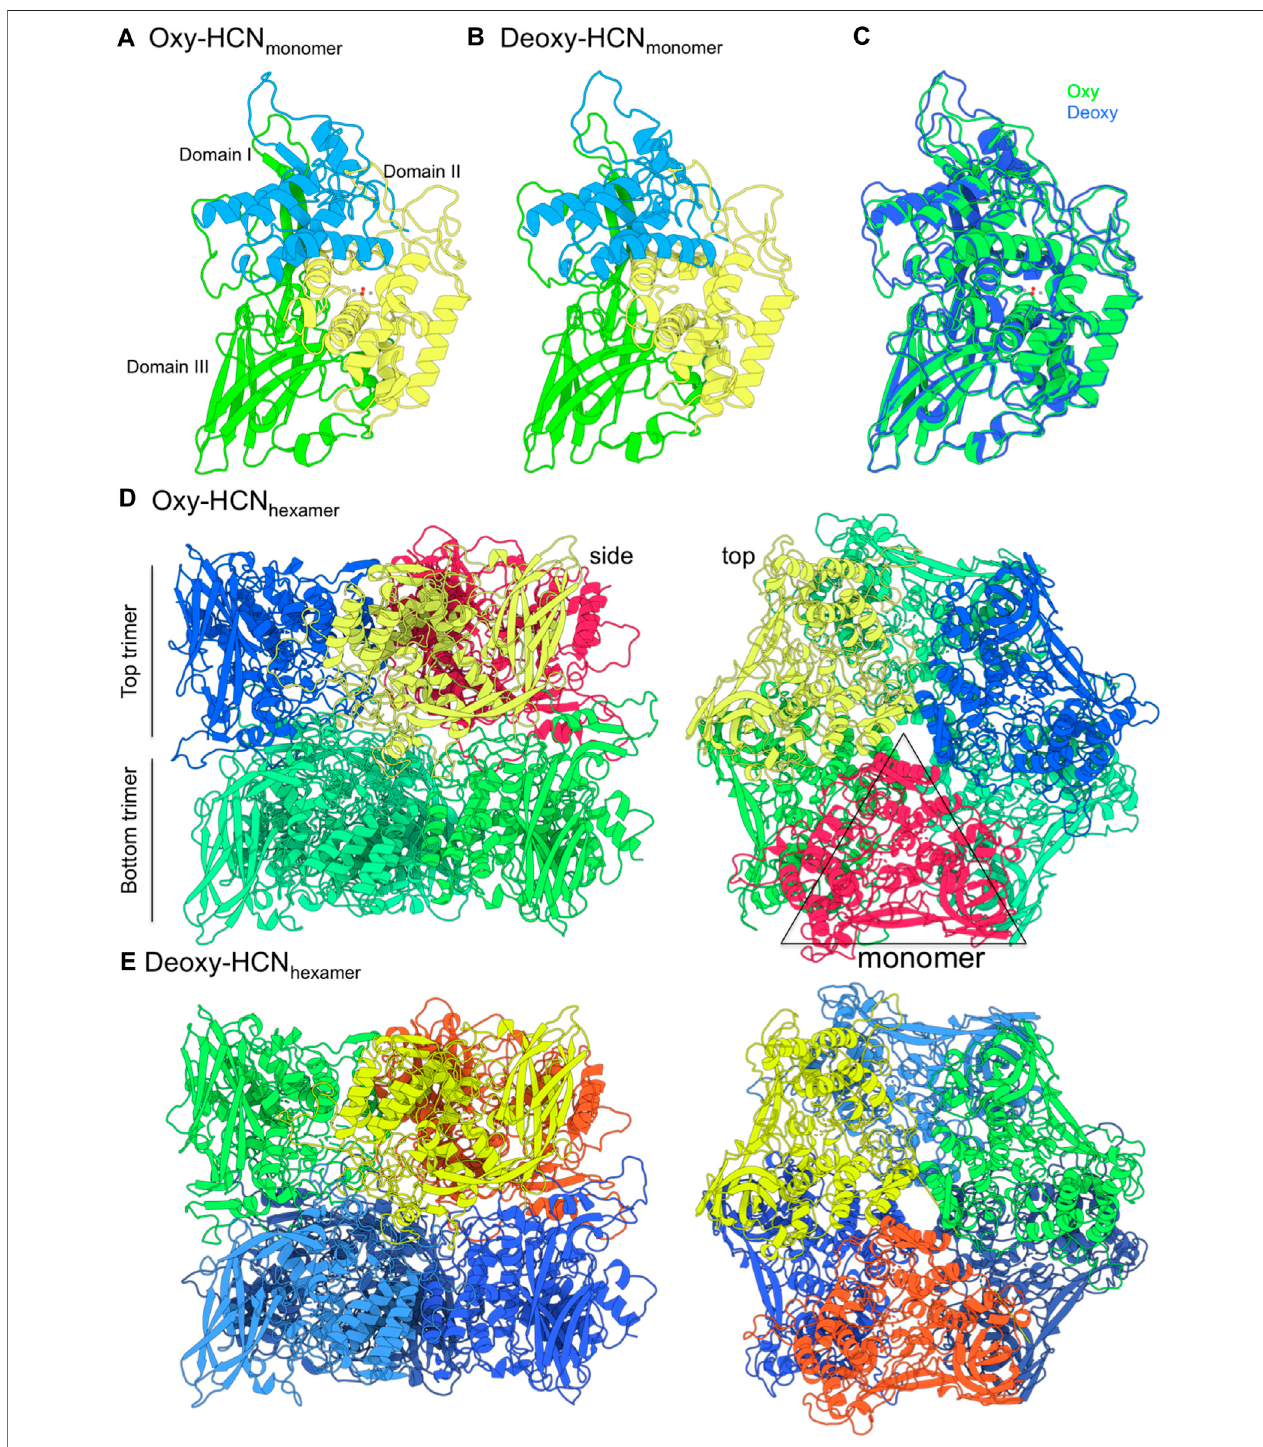
FIGURE1| Thestructureofhemocyanin(HCN)from Limuluspolyphemus inoxygenated(Oxy)anddeoxygenated(Deoxy)states. (A,B) Thestructureismadeupof six identical monomers. Each monomer consists of three domains. Domain II contains the copper binding site (grey spheres) that coordinates oxygen atoms (red spheres). (C) The monomers from Oxy and Deoxy states differ primarily in the conformation of the loops. (D,E) The structure is composed of two concentric layers of homotrimers and arrangedas a “ dimer-of-trimers. ” Monomer subunits in each top trimer are represented ina different color. The bottom trimer units are colored in green (Oxy-HCN) and blue